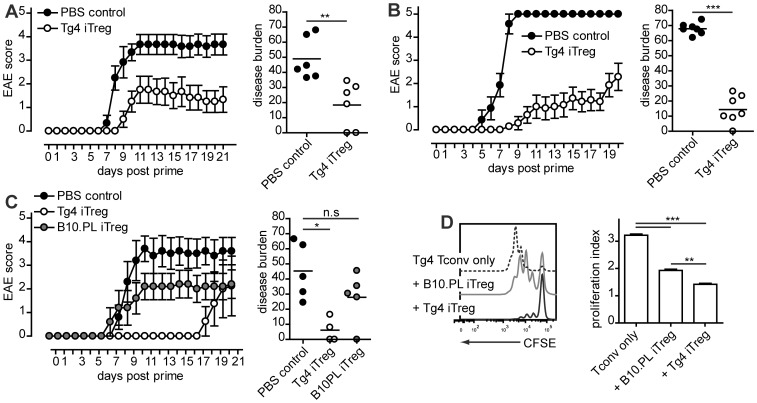
Antigen-specific iTreg cells ameliorate EAE progression.A–C. Mice received 5×106 iTreg cells in PBS or PBS only i.p. 2–3 days prior to EAE induction with MBP Ac1–9 in CFA. A. Tg4 Rag+/+ recipients. N = 6 per group, combined from 2 individual experiments. ** P = 0.0022, Mann Whitney test. B. Tg4 Rag−/− recipients. n = 7 per group, combined from 3 individual experiments. *** P = 0.0006, Mann Whitney test. C. Tg4 Rag−/− recipients. PBS control and B10.PL iTreg n = 5, Tg4 iTreg n = 4, combined from 2 individual experiments. * P< 0.05, Kruskal Wallis with Dunn's post-test. A-C EAE plots depict mean ± SEM. Horizontal lines in disease burden scatter plots indicate mean. D. Tg4 CD45.1 naive CD4+ T cells, labeled with CFSE, were cultured alone or co-cultured at a 1 to 1 ratio with B10.PL or Tg4 (both CD45.2+) iTreg cells for 4 days and stimulated with 1 µg/ml MBP Ac1–9. CFSE dilution was measured by FACS (gated on CD45.1+ cells) and proliferation indexes calculated using FlowJo software. Bar graph shows mean ± SEM. One experiment of 3 similar experiments in triplicate is shown. ** P<0.01, *** P<0.001, Tukey's multiple comparison test.